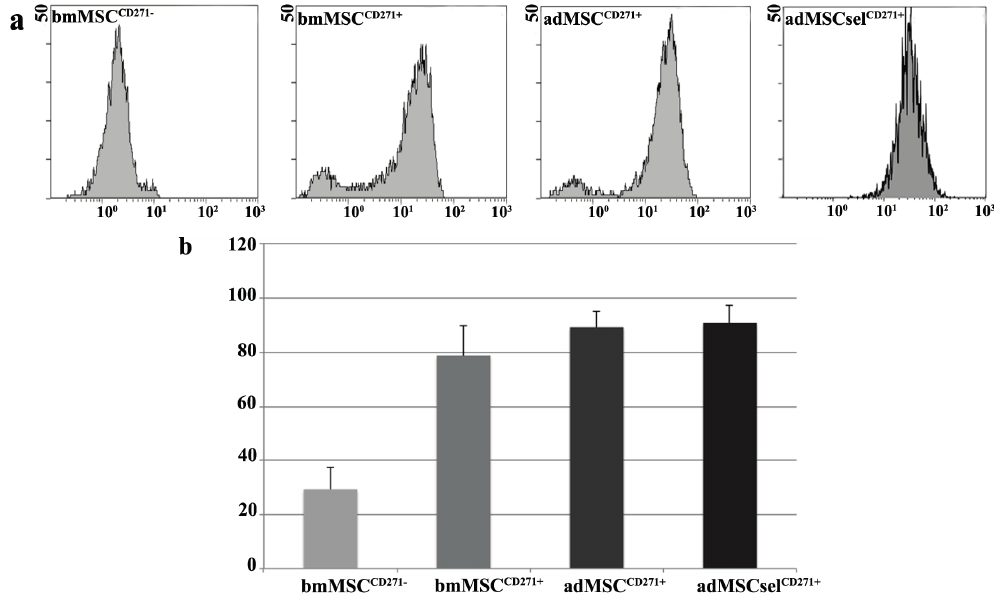
Figure 1. Flow cytometry expression of CD271 in bmMSC CD271 − , bmMSC CD271+ , adMSC CD271+ and adMSCsel CD271+ lines; ( a ) Representative histograms of only one for each type of the four different cell lines; ( b ) Average Percentage of CD271 + cells in the four different cell